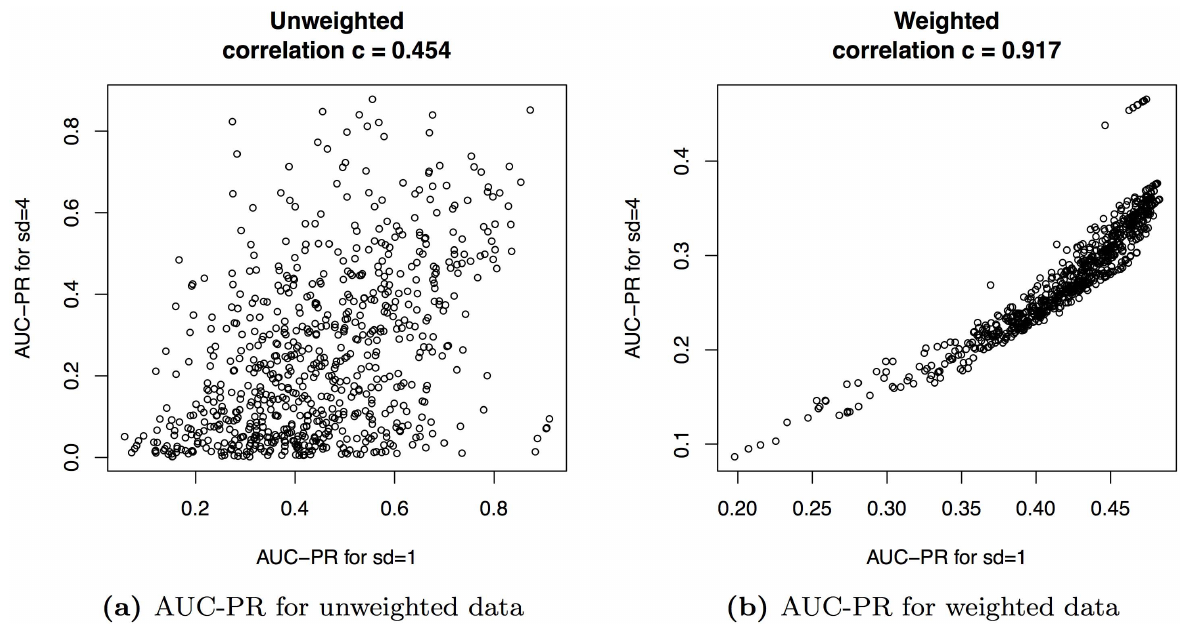
Figure 8. Comparison of AUC-PR values for different classification thresholds. In panel (a), we consider unweighted test data and plot the AUC-PR values for a threshold of mean intensity plus four times standard deviation (ordinate) against the AUC-PR values for a threshold of mean intensity plus four times standard deviation (abscissa). In panel (b), we consider weighted test data and plot the AUC-PR values in analogy to panel (a). We find a substantially greater Pearson correlation between the AUC-PR values for the different thresholds for weighted data compared to unweighted data.